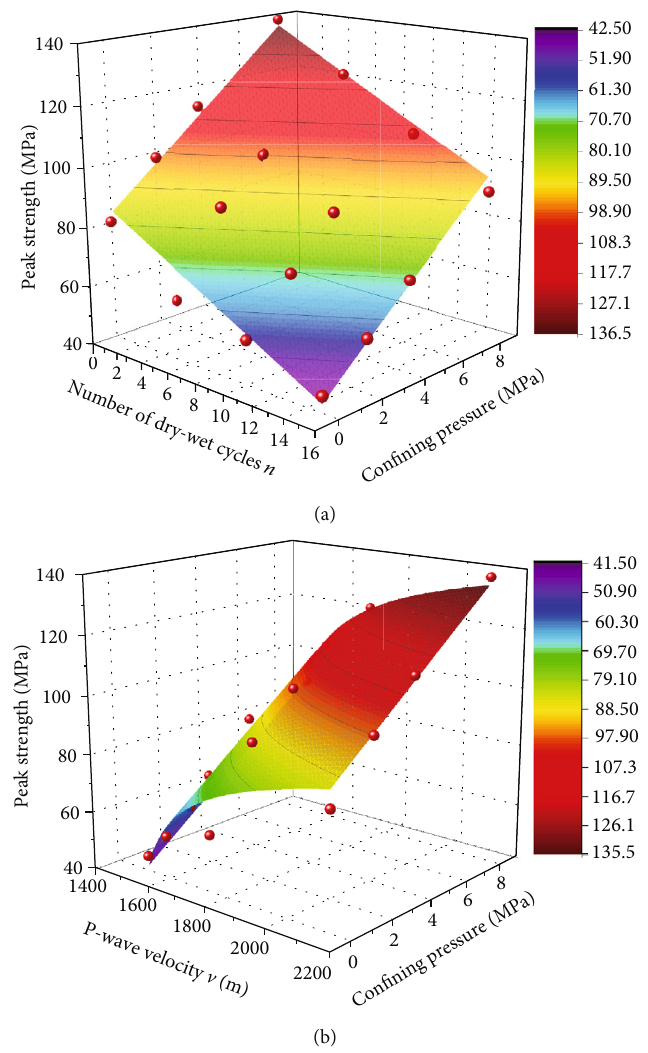
Figure 10: Peak intensity decay prediction